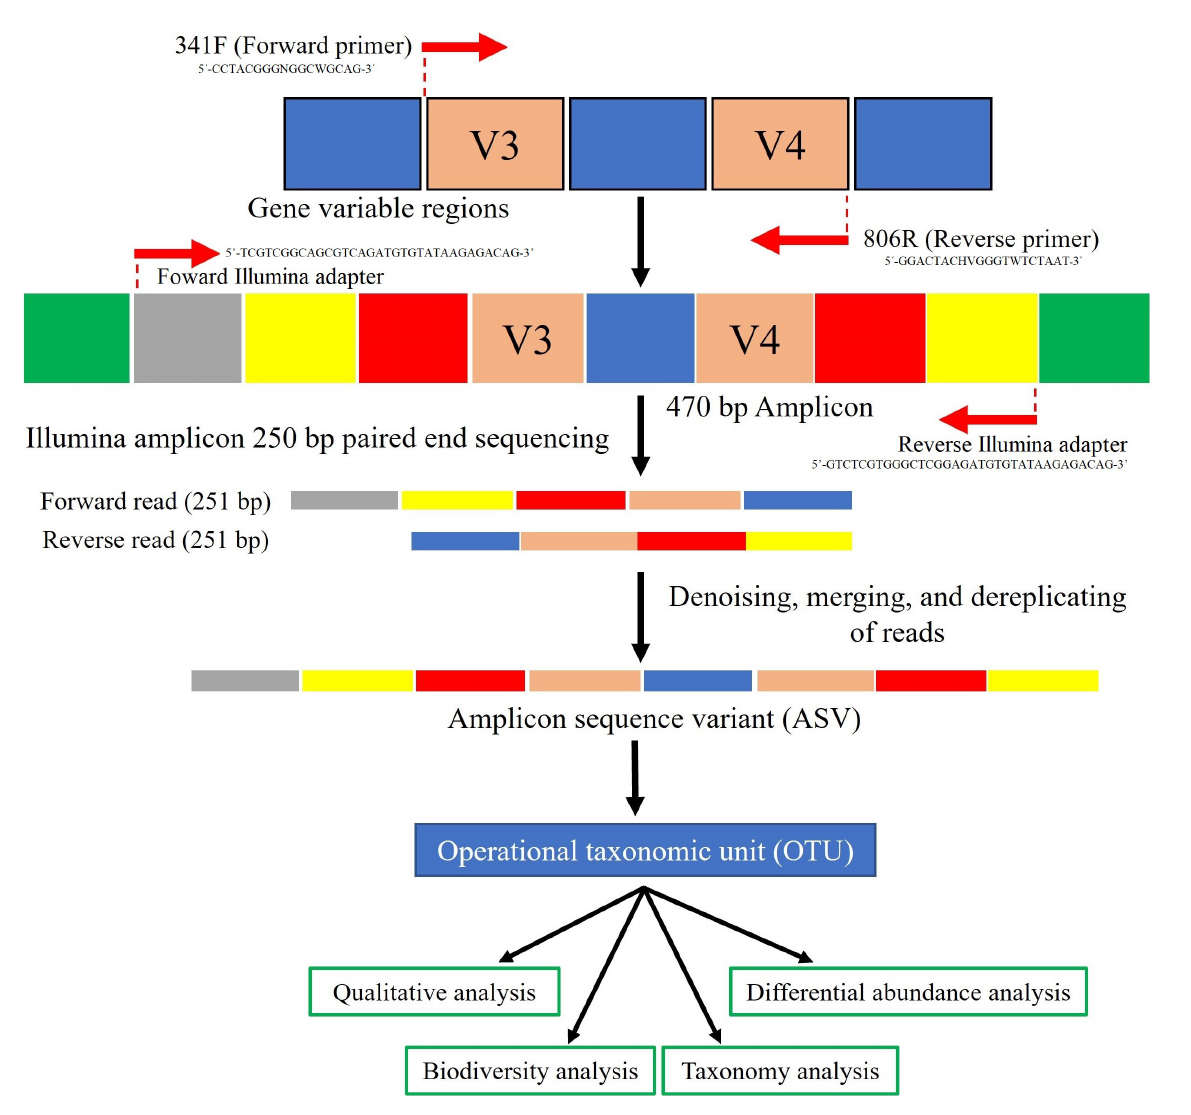
FIGURE3 Flow diagram representing the strategy employed for 16S rRNA amplicon sequencing and raw data processing. Reads were denoising by the DADA2 package (https://github.com/benjjneb/dada2) and the rest of the procedures using QIIME2 v2020.8